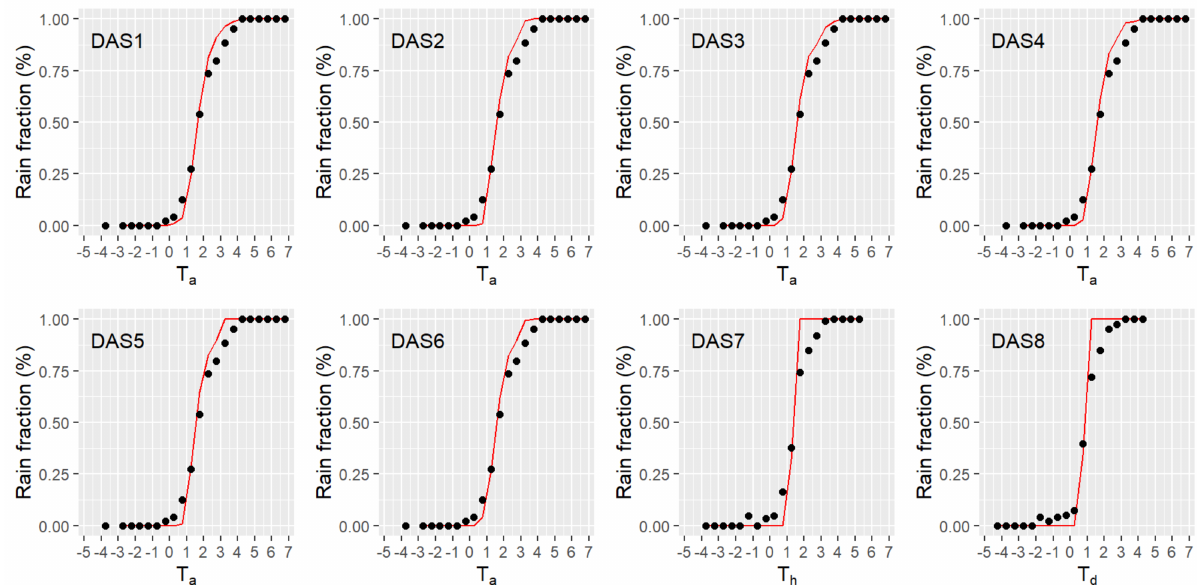
Figure 7. Precipitation phase plots using artificial neural networks for DAS1 to DAS8 from left to right and from top to bottom. The black dots represent observed values, and the red lines represent the simulations by ANN models.